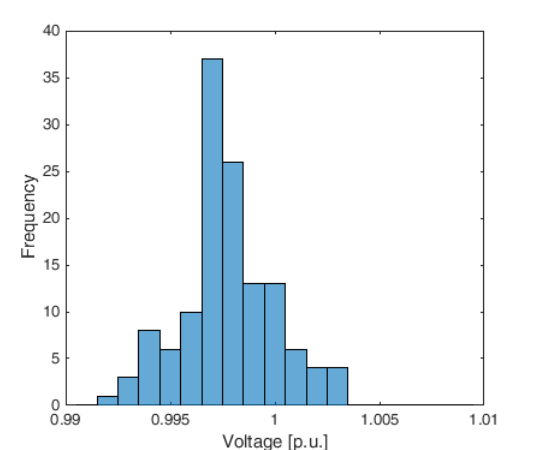
Figure 7. The histogram of the distribution of the nodal voltage amplitudes for the partitioning in four VCZs in Case 3 .